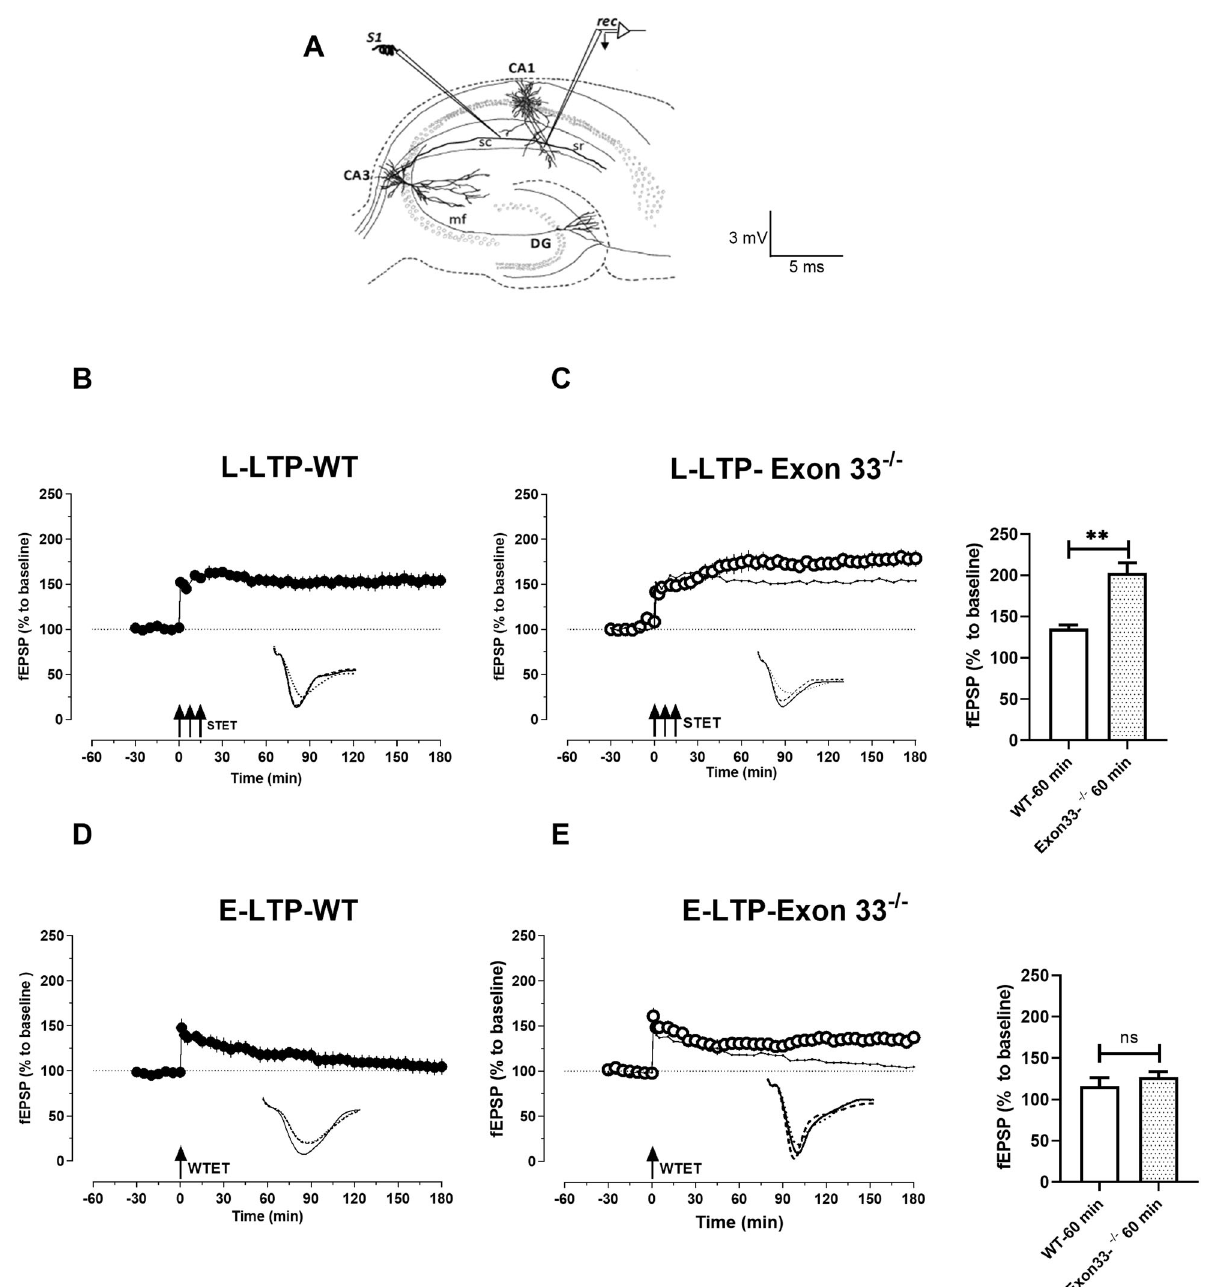
Fig. 1 Exon 33 -/- mice displayed enhanced LTP and reinforced E-LTP to L-LTP. A Schematic representation of a transverse hippocampal slice showing the positioning of electrodes in the CA1 region of hippocampus. One stimulating electrode S1 was placed in the stratum radiatum to stimulate Schaffer collateral fi bres and a recording electrode ‘ rec ’ was placed in the CA1 apical dendritic region. B STET in synaptic input S1 resulted in a statistically signi fi cant potentiation that maintained for 180 min in WT mice ( P = > 0.05, n = 9). C STET in Exon 33 − / − mice also resulted in a long-lasting LTP with a higher percentage of potentiation than WT (Fig. 1B) from 30 min and remained stable for 180 min (U-test, 30min, P = 0.002; 60min, P = 0.002; 120 min, P = 0.002;180 min, P = 0.009, n = 9). Dotted line represents Fig B for comparison. D WTET in WT resulted only in a short- lasting LTP that decayed to the baseline (Wilcox, 15min, P = 0.03, n = 7). E WTET in Exon 33 − / − mice resulted in a long-lasting LTP that remained signi fi cant until 180 min ( P = > 0.05, n = 7). Dotted graph represents D for comparison. The dotted line at 100% represents a line for reference. Error bars in all graphs indicate ±SEM. Analog traces represent typical fEPSPs of input S1 recorded 15 min before (dotted line), 30 min after (dashed line), and 180min (solid line) after tetanisation. Bar graph represents the comparison of potentiation between WT and Exon 33 − / − mice at 60 min post tetanisation. Three solid arrows represent the time of induction of L-LTP by STET for the induction of late-LTP. Single arrow represents the time point of induction of E-LTP by WTET. Scale bars: vertical, 2mV; horizontal, 3ms. STET-strong tetanisation, WTET-weak WT and Exon 33 − / − mice (Fig. 3A, B). We choose the behavioural memory, only if it occurs in close temporal association with a strong stimulation (novel environment (NE)) that induces the tagging (BT) paradigm as it shows subtle differences in the synthesis of plasticity proteins [46]. We therefore investigated behaviour [47]. In the control group (weak inhibitory avoidance associative memory using a behavioural tagging (BT) paradigm in (IA) alone), the animals were subjected to a weak foot shock that